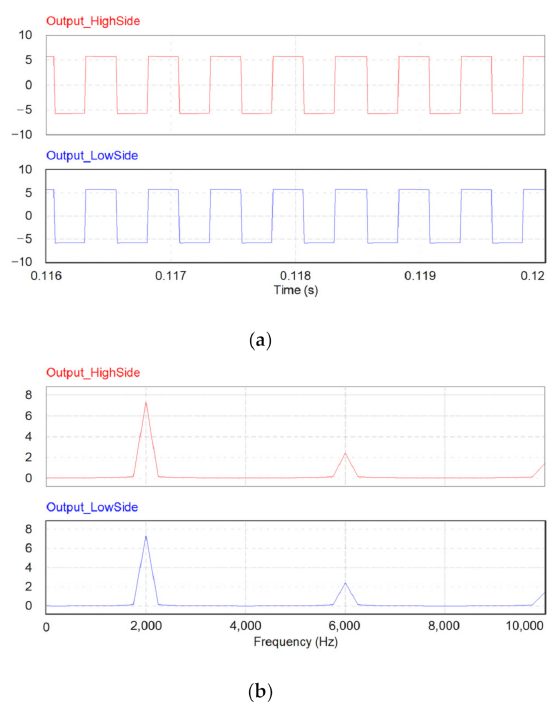
Figure 13. Frequency and FFT characteristics of Zone 4: ( a ) frequency characteristics of Zone 4 (2 kHz + 2 kHz); ( b ) FFT characteristics of Zone 4 (2 kHz + 2